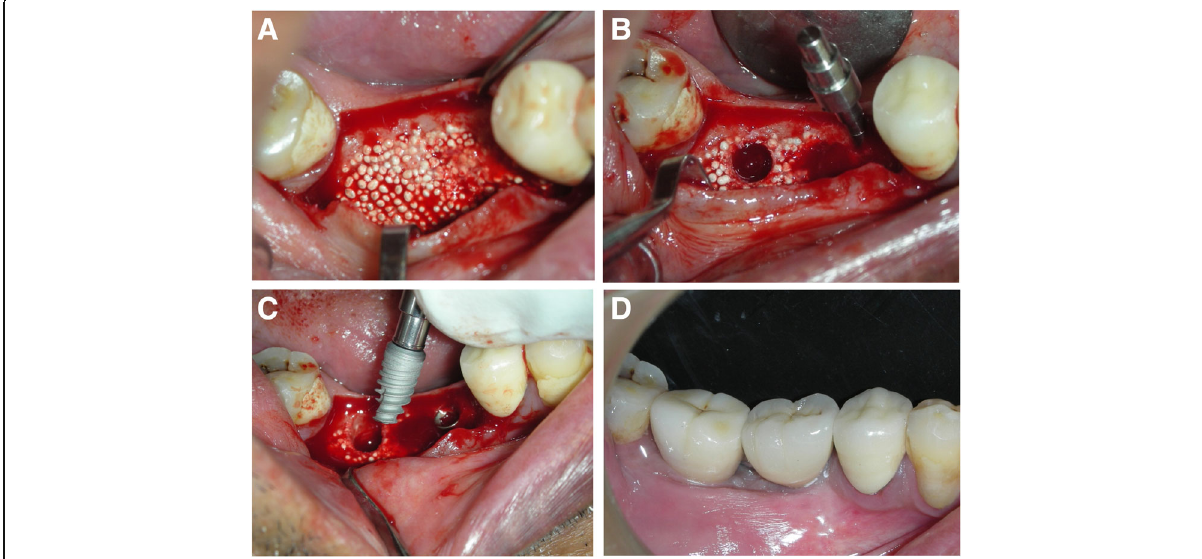
Fig. 2 a Mucoperiosteal flap reflection post healing and graft consolidation showing the graft well integrated into the native bone and an increased width of the alveolar ridge. b Two core biopsy samples harvested from the augmented area. Anterior implant preparation was done. c Implant insertion into the site. Note that a wide-diameter implant was placed into the second molar area. d Two individual implant crowns were placed as the final